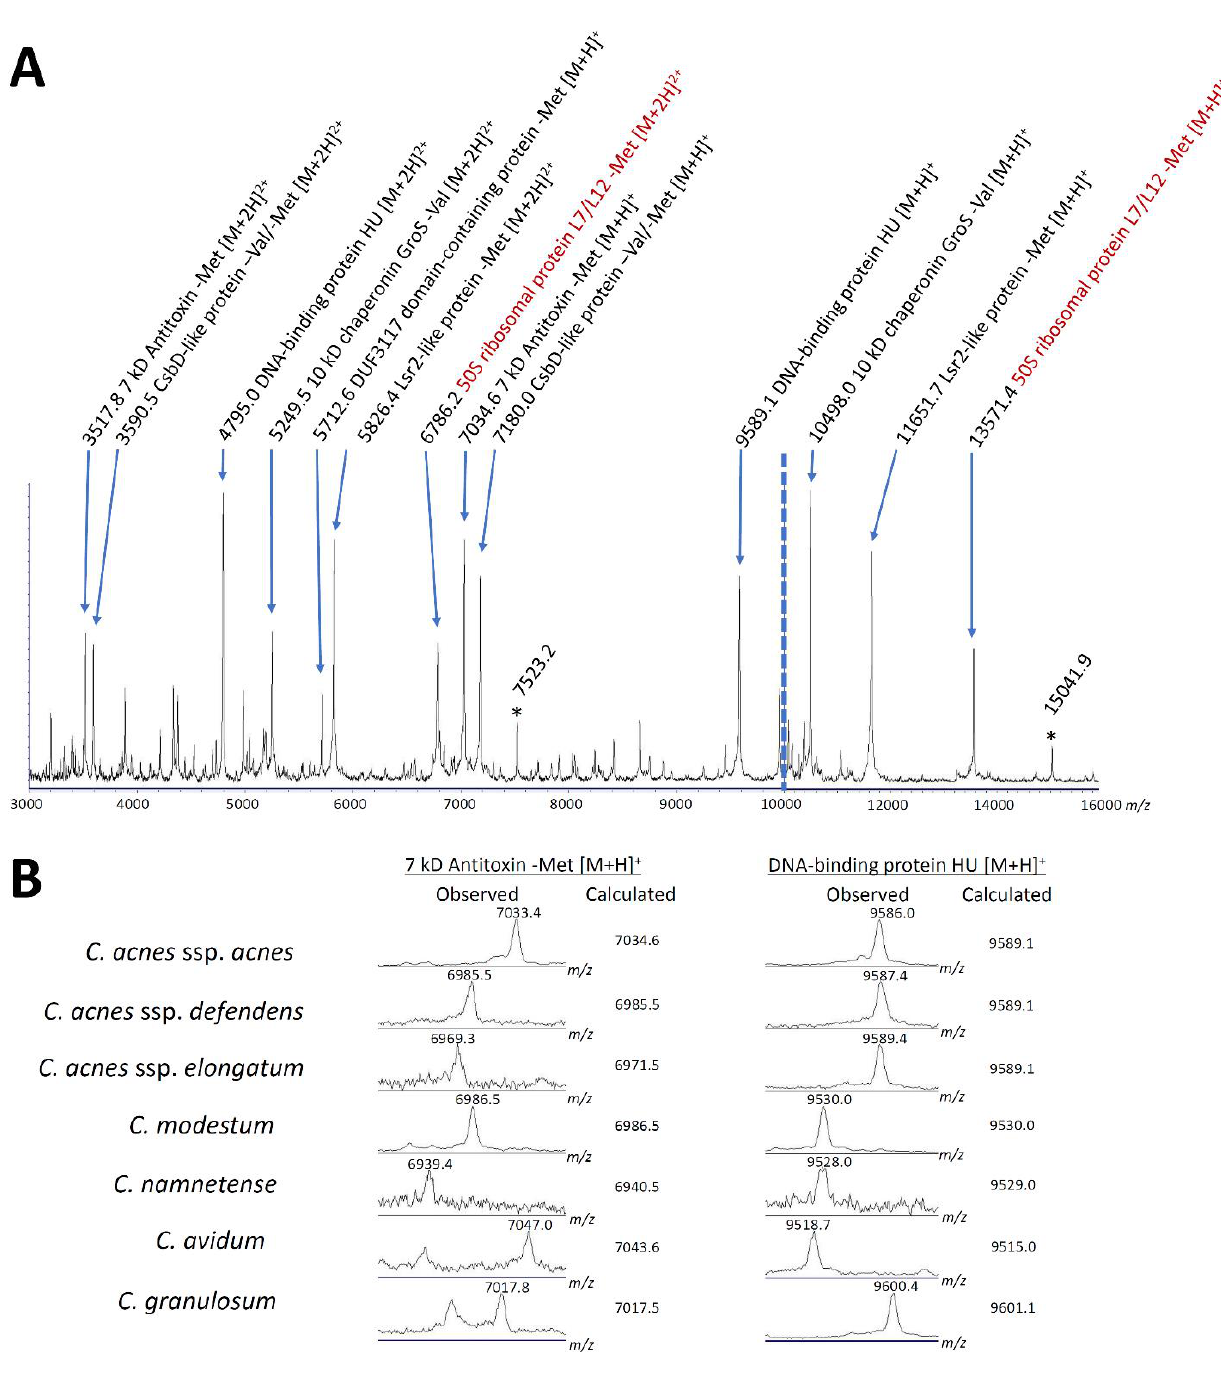
Figure 4. Assignment of prominent MALDI peaks of Cutibacterium acnes . ( A ) Peak assignment on the overall spectra of C. acnes subsp. acnes JCM 6425 T . Both x - and y -axes are different between 3000–10,000 m / z and 10,000–16,000 m / z ranges. Numbers before protein assignments are calculated m / z values (observed m / z values, see Table S2). Brown letters indicate ribosomal subunit proteins. -Met, -Val: methionine and valine at N-terminus deleted from original translations. * Nutrition-dependent peaks yet to be identified (singly and doubly charged ions of the same protein). ( B ) Examples of assignment by comparing the observed and calculated peaks. The calculation was performed by a bottom-up approach based on UPLC–MS/MS profiling of the proteins.